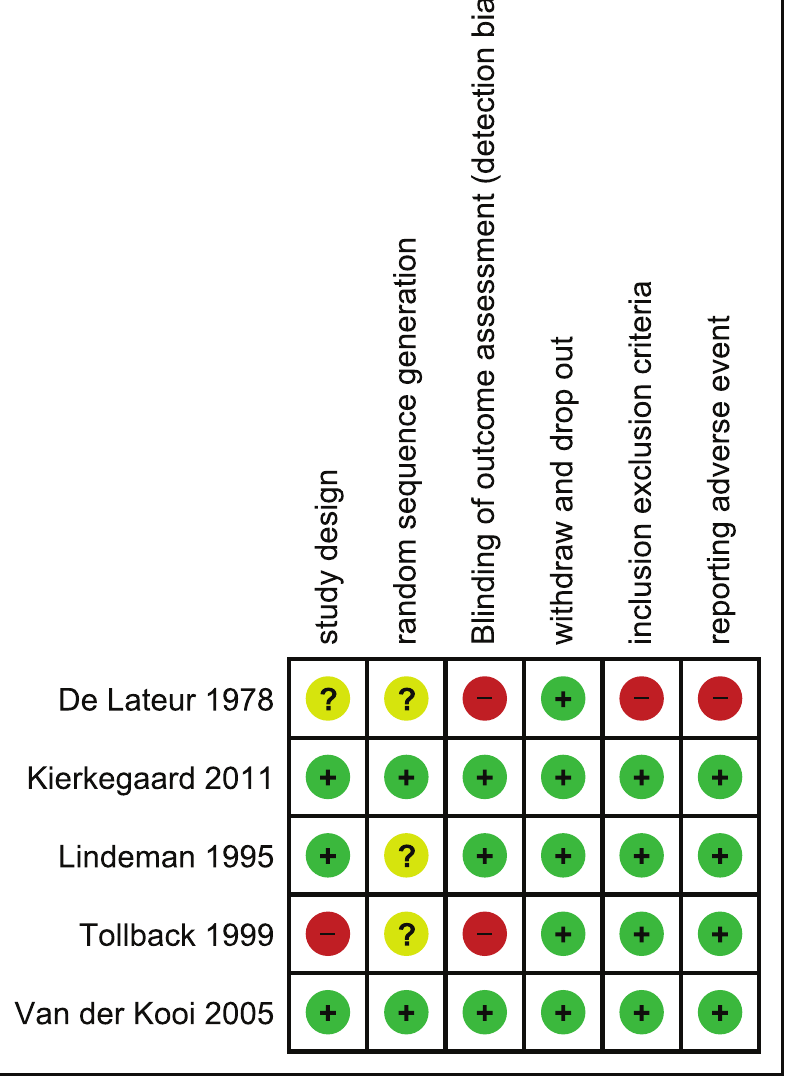
Figure 2. Risk of bias table. Legend: Red (-)=high risk of bias; Yellow (?)= unknown risk of bias; Green ( + )= low risk of bias. age of participants ranged from 4 to 11 years. All trials were conducted in Western countries between 1978 and 2011.